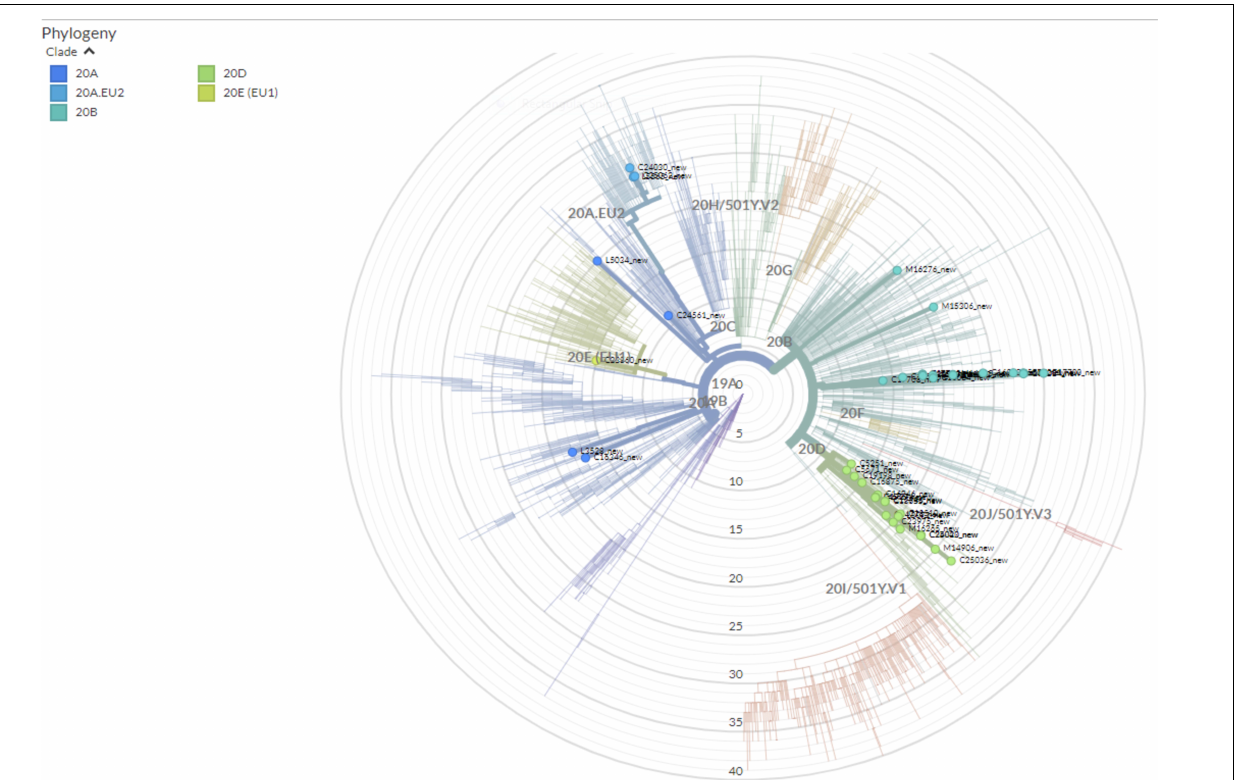
FIGURE 3 | The phylogenetic tree of all SARS-CoV-2 isolates globally representing position and clade clustering (Nextrain nomenclature) of Serbian isolates of SARS CoV2 from the second wave of the pandemic. The tree was made online with Nextclade (https://clades.nextstrain.org/) without any restrictions on use.